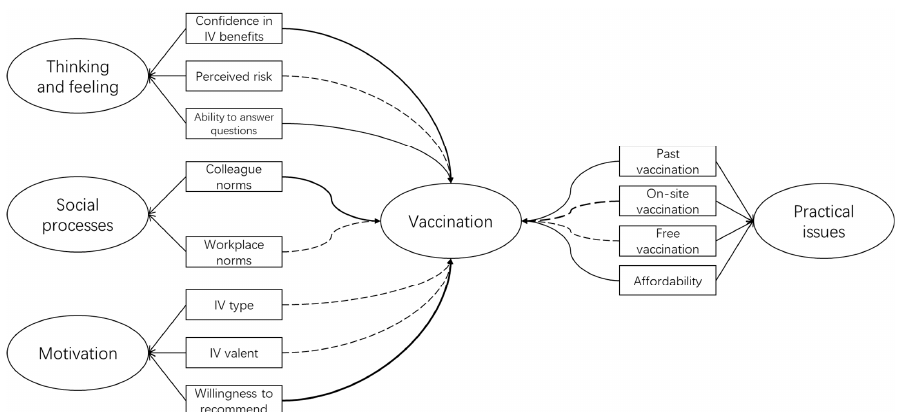
Figure 1. Behaviour and social drivers of influenza vaccination. Solid lines showed each level was significantly influenced by Chinese healthcare workers influenza vaccination, while broken lines showed healthcare work with some levels of the item were significantly affected when taking the high acceptance group as a reference. The thickness of lines was used to call attention to the drivers that matter most according to adjust odds ratio by multivariable logistic regression analysis. Signif- icant refers to the difference among all levels of the item reached statistically significant in the lo- gistic regression analysis; partially significant refers to not all levels of the item being statistically significant. IV: Influenza vaccine. Table 2. Factors associated with influenza vaccine willingness-multivariable logistic regression analysis (reference: high acceptance group).